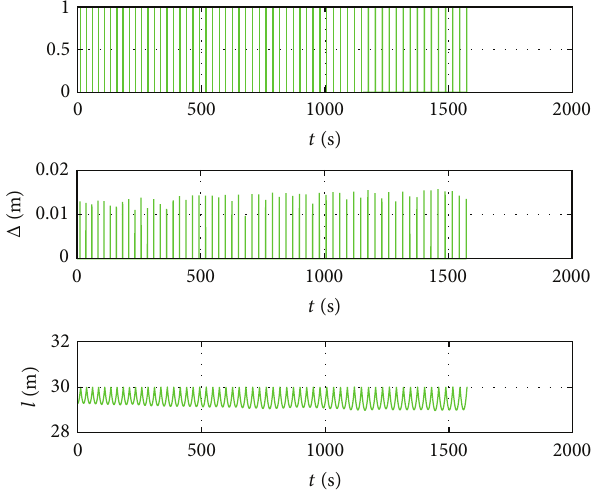
Figure 21: The tensional and tensionless states, the elongation of the tether, and the distance between the two